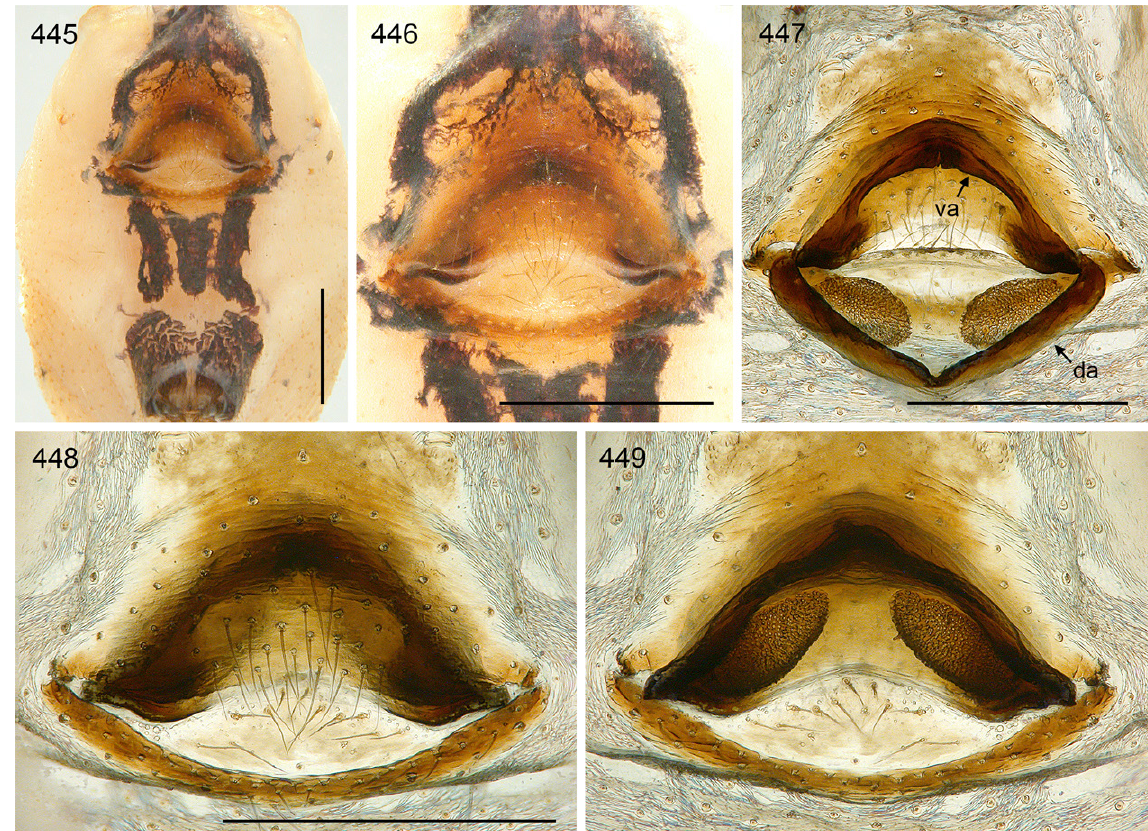
Figs 445–449. Crossopriza tiwi sp. nov.; female from Oman, Wadi Tiwi (ZFMK Ar 22403). 445– 446 . Abdomen and epigynum, ventral views. 447–449 . Female internal genitalia, dorsal view (with dorsal arc tilted backwards), ventral view, and regular dorsal view. Abbreviations: da = dorsal arc; va = ventral arc. Scale bars = 0.5